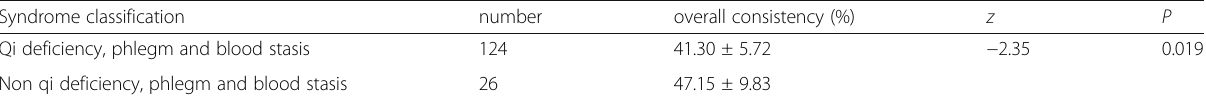
Table 7 Comparison of overall consistency between qi deficiency, phlegm and blood stasis syndrome and non- qi deficiency,